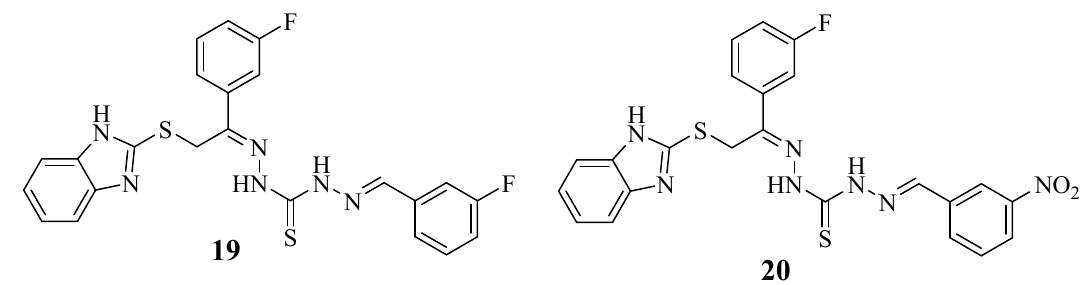
Figure 5. Structure–activity relationship of derivatives 19 and 20 .